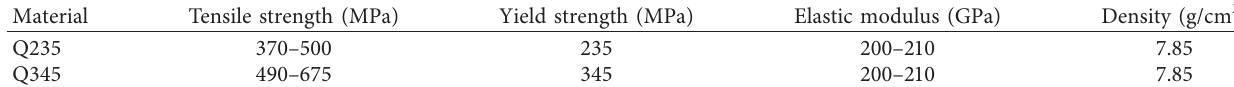
Table 2: Mechanical parameters of Q235 and Q345.